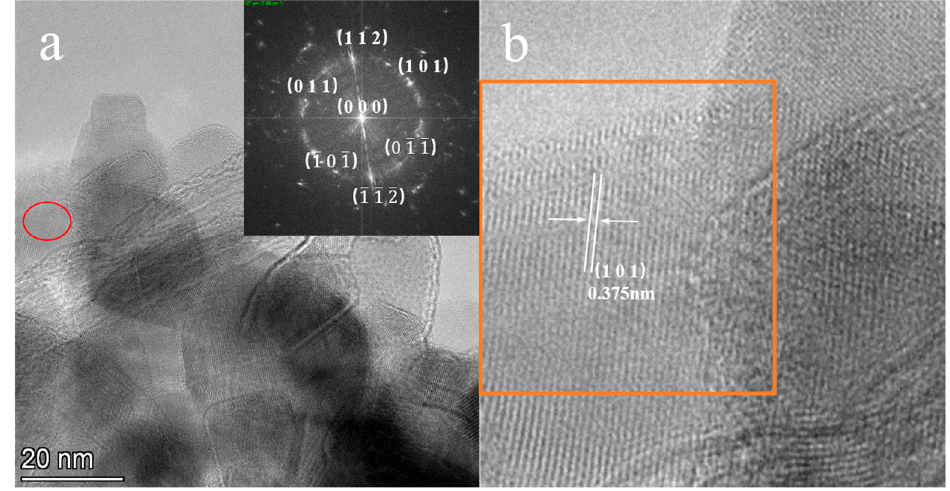
Figure 3. TEM ( a ) and high-resolution TEM ( b ) images of the TiO 2 /CNT mesoporous nanomateri- als.